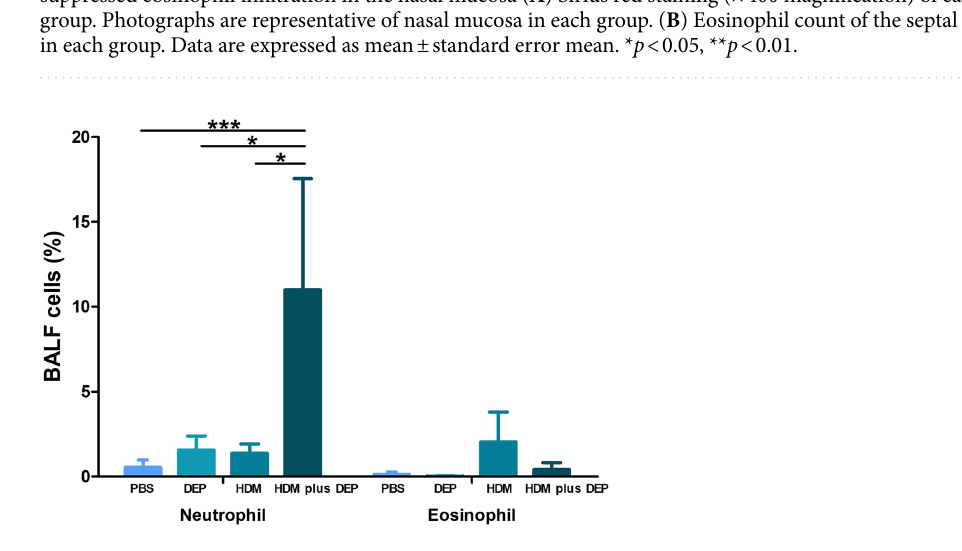
Figure 4. Differential counts in BALF. Significantly increased proportion of neutrophils in the BALF is seen in the HDM and DEP co-exposed group (group D). * p < 0.05, *** p <